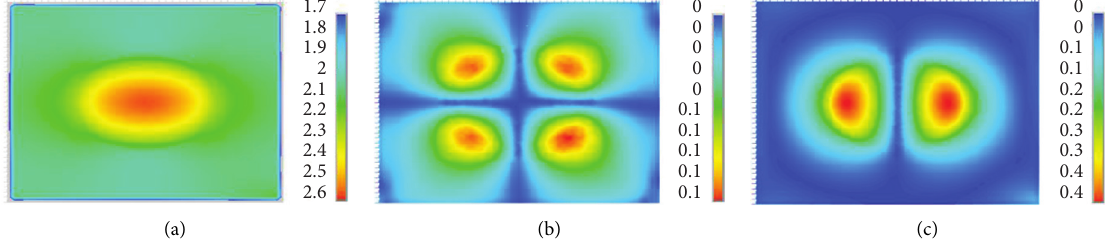
Figure 55: SV wave incident (3D sedimentary hemispheric basin, f � 1.5Hz, R � 100m, and C view (a) u x , (b) u y , and (c) u z .